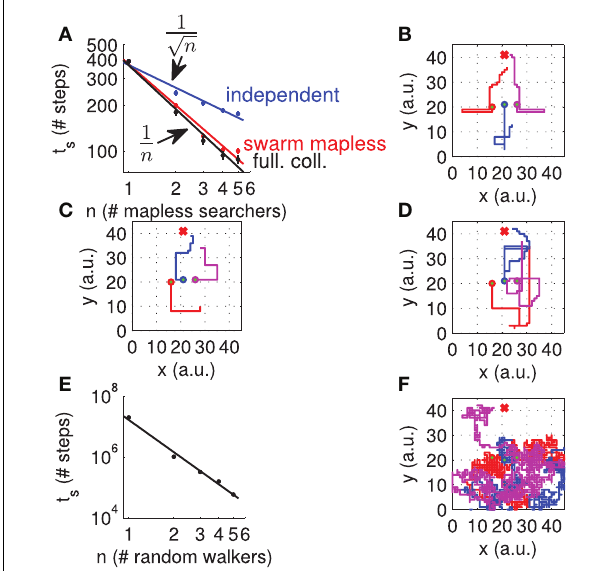
FIGURE 1 | Efficiency of swarm Mapless in simulation . (A) Dependency of the search time t s on the number of Mapless searchers n . Simulations were performed in C on Ubuntu Linux (2.2GHz). Sensory information is binary (detection/no detection). The environmental parameters used in the simulations are (in arbitrary units) the emission rate at the source J = 1, diffusivity D = 1, lifetime of particles τ = 400, and wind speed V = 0 leading to a correlation length λ = 20. The other Mapless parameters to compute the free energy are the scaling factors λ u = 0.5 λ and λ G = λ for the detection and non-detection events, the number N M = 750 of visited locations stored in memory and the internal temperature T = 1. Blue, red, and black plots are in log–log scale for independent searchers, swarm Mapless, and fully collaborative searchers, respectively. Points are means ± SEM estimated over 2000 simulations. Solid lines represent power law fits t s ∝ n β . The exponent β is − 0.9 for swarm Mapless, − 0.95 for fully collaborative searchers and − 0.5 for independent searchers so that the search time decays as 1/n for √ n for independent searchers. (B–D) Examples of swarm Mapless and 1/ swarm Mapless trajectory with three searchers. The source is located at (21, 41). The agent starting points are (16, 20), (21, 21), and (26, 21). (E) Dependency of the search time t s on the number of independent random walkers n . Same conditions as in (A) . (F) Example of search path with three independent random walkers. Same conditions as in (B)